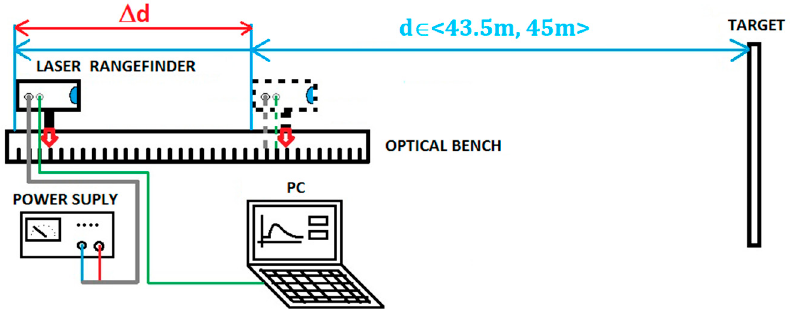
Figure 10. The schematic diagram of the test stand.